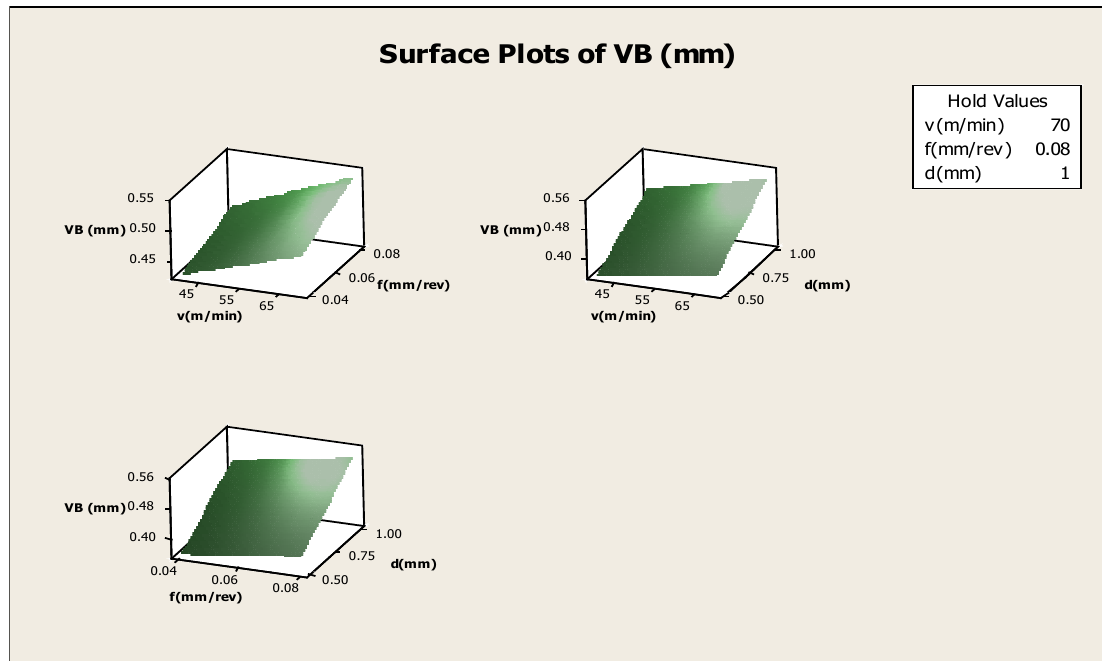
Figure 7. Surface plots for flank-wear.